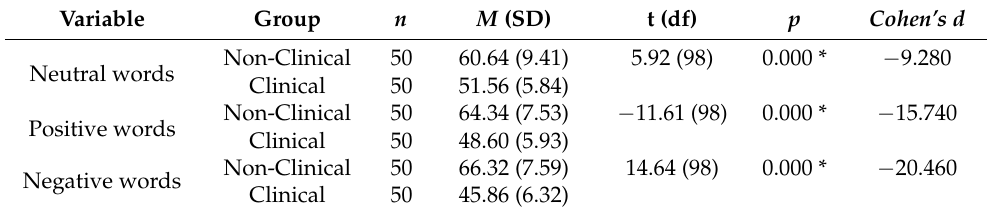
Table 5. Results for neutral, positive, and negative words scores by non-clinical and clinical groups. Variable